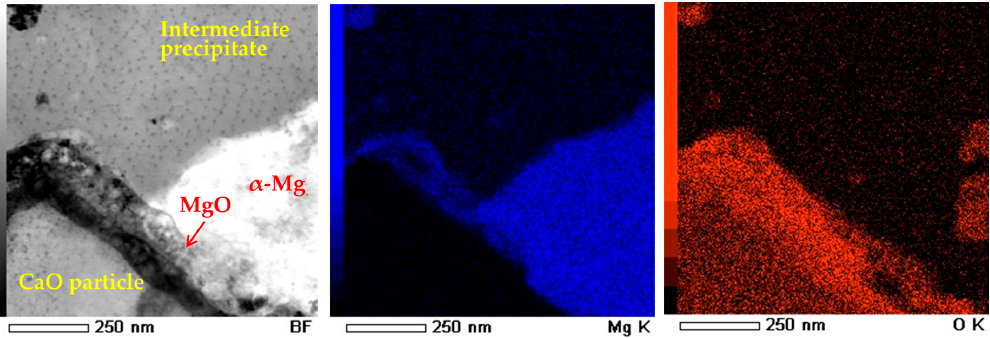
Figure 9. TEM-energy-dispersive spectroscopy (TEM-EDS) mapping analysis around CaO particle in the Mg–Al–CaO precursor with 10-vol % CaO particles after the heat treatment at 500 ◦ C for 300